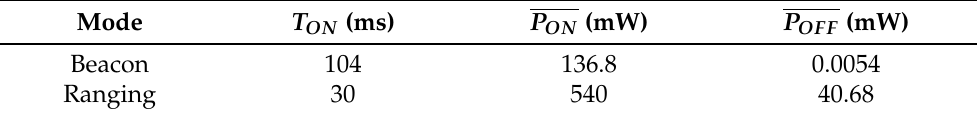
Table 4. Anchor: average power consumptions and time durations for the different modes.